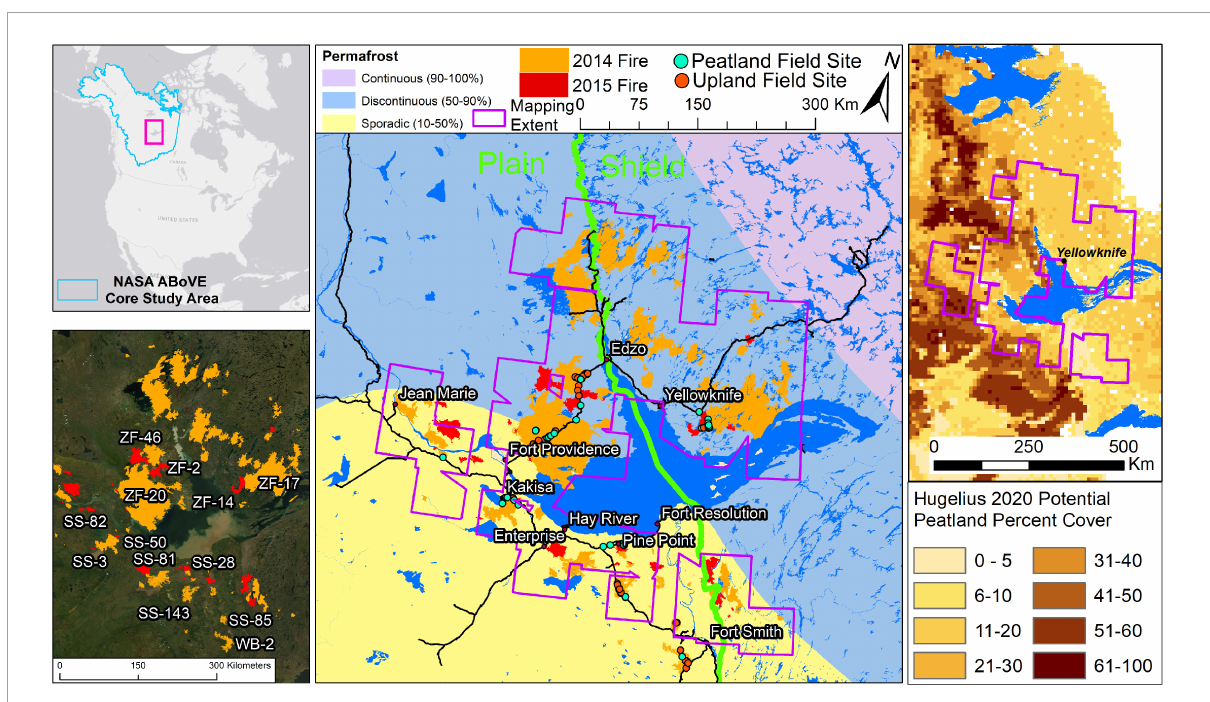
FIGURE1 Map of Northwest Territories and northern Alberta showing 136 wildfires (2014–2015) within the study area around the Great Slave Lake and boundaries of ecoregions, permafrost zones, and location of field sites.